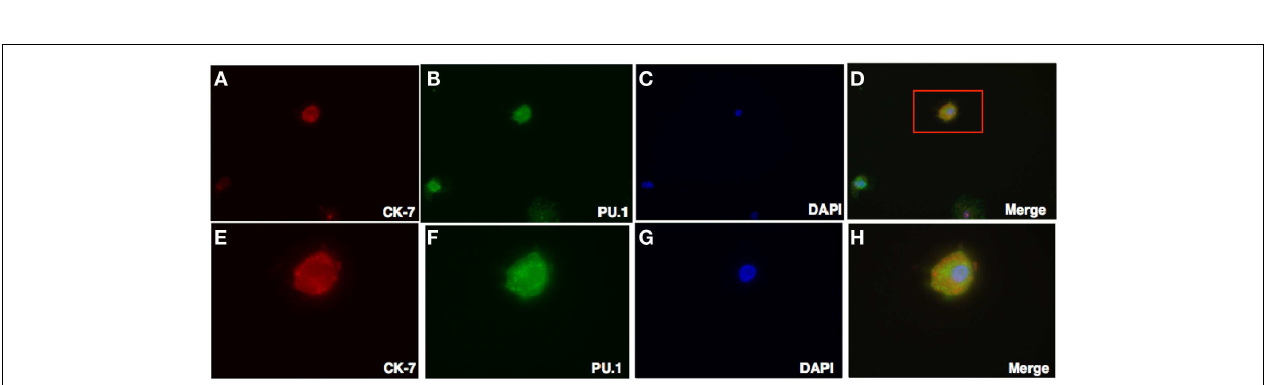
FIGURE 5 | Double immunofluorescence staining of PU.1 and stromal cells in first trimester decidua . Pure population of stromal cells over coverslips was immunostained with mouse anti-human vimentin and rabbit